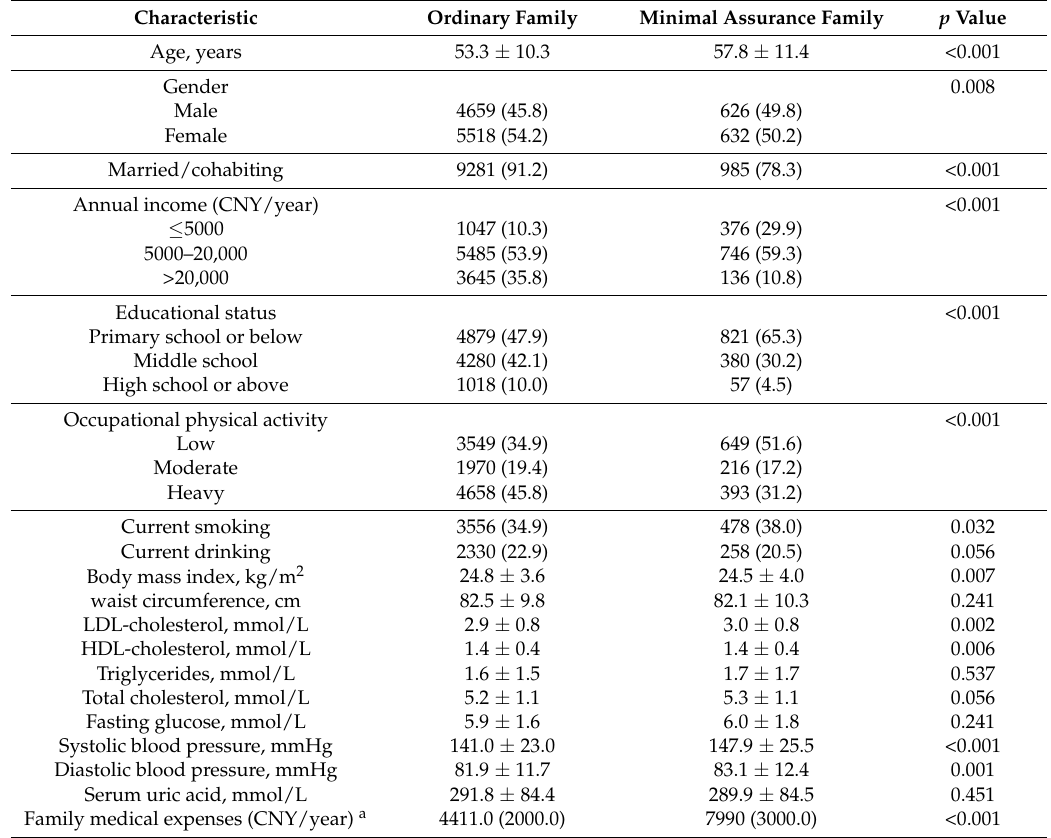
Table 1. Sample characteristics of the minimal assurance